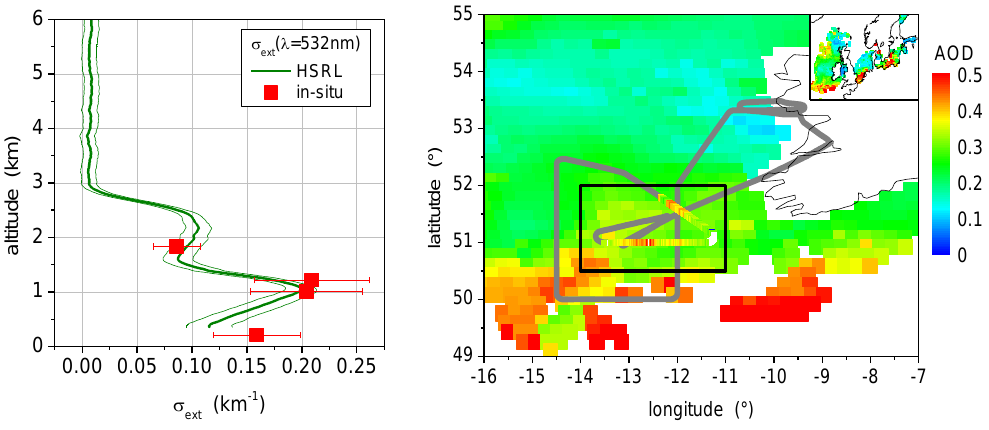
Fig. 9. Long-range transported central European pollution observed over the Atlantic off the west coast of Ireland on 14 May 2008. (a) Averaged vertical profile of the aerosol scattering coefficient as measured by High Spectral Resolution Lidar (HSRL; green line) and derived from the in situ particle size distribution measurements (square symbols) on board the DLR Falcon. (b) Map of aerosol optical thickness (AOD) at 532nm wavelength retrieved from satellite (PARASOL) and HSRL measurements colour coded, where available, on the Falcon flight